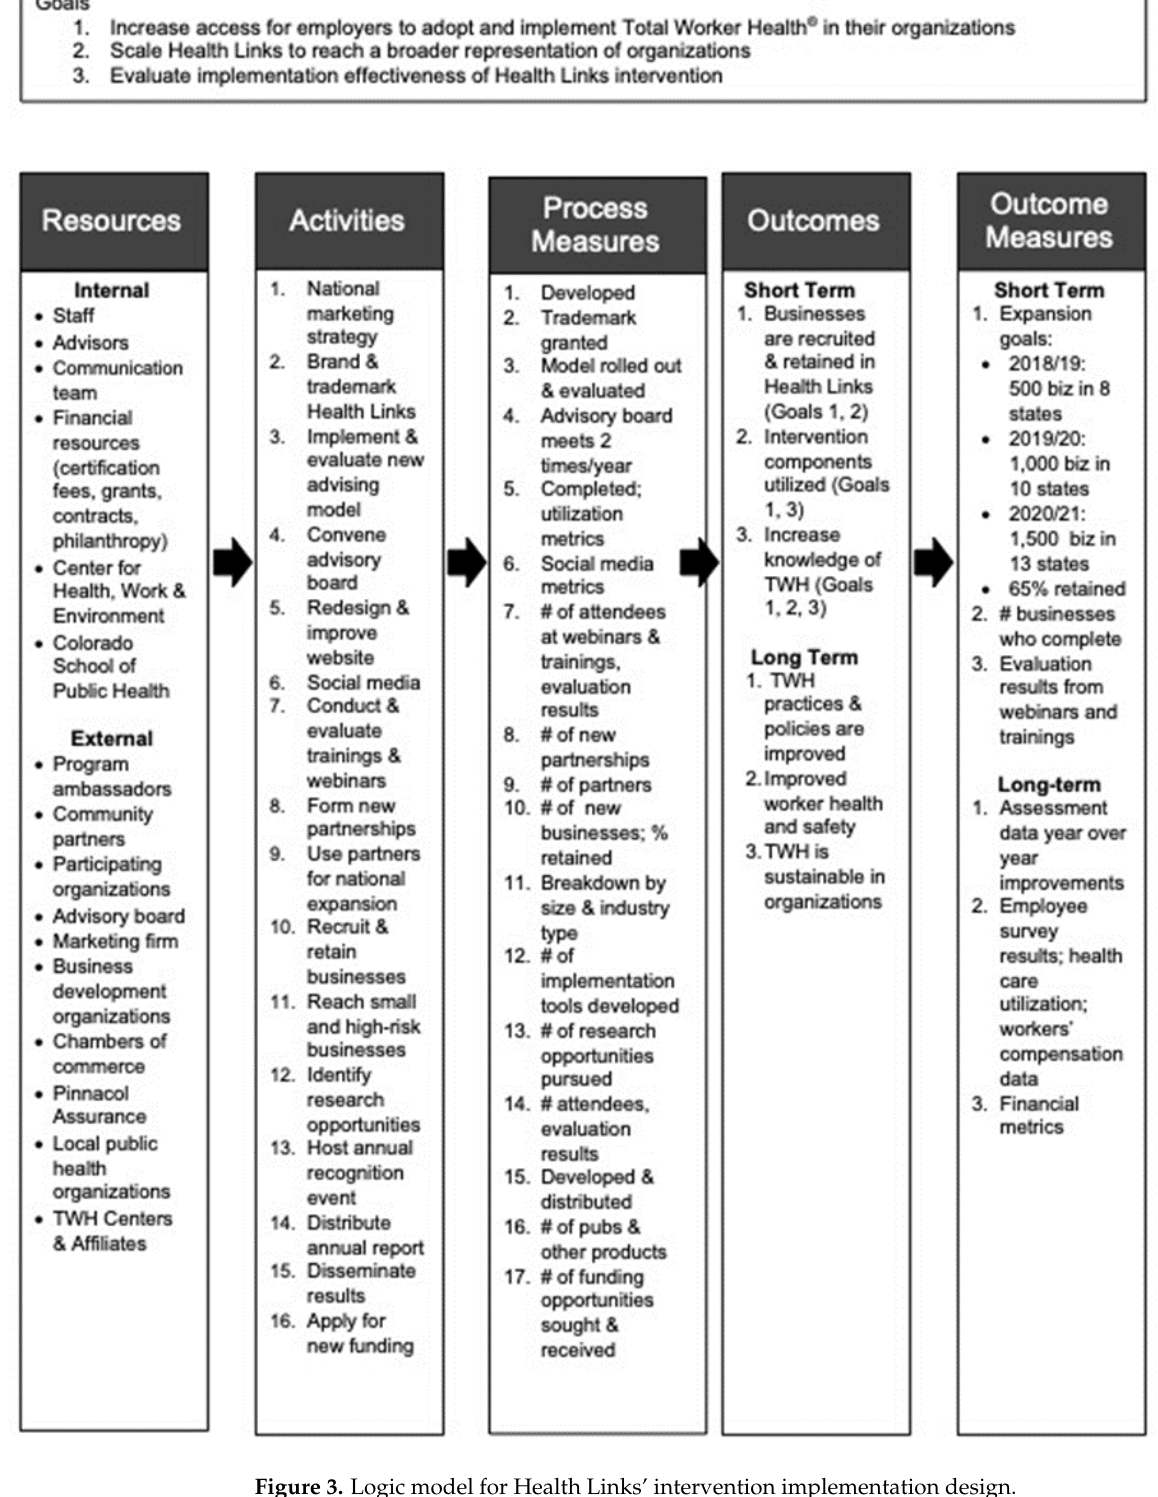
Figure 3. Logic model for Health Links ’ intervention implementation design.